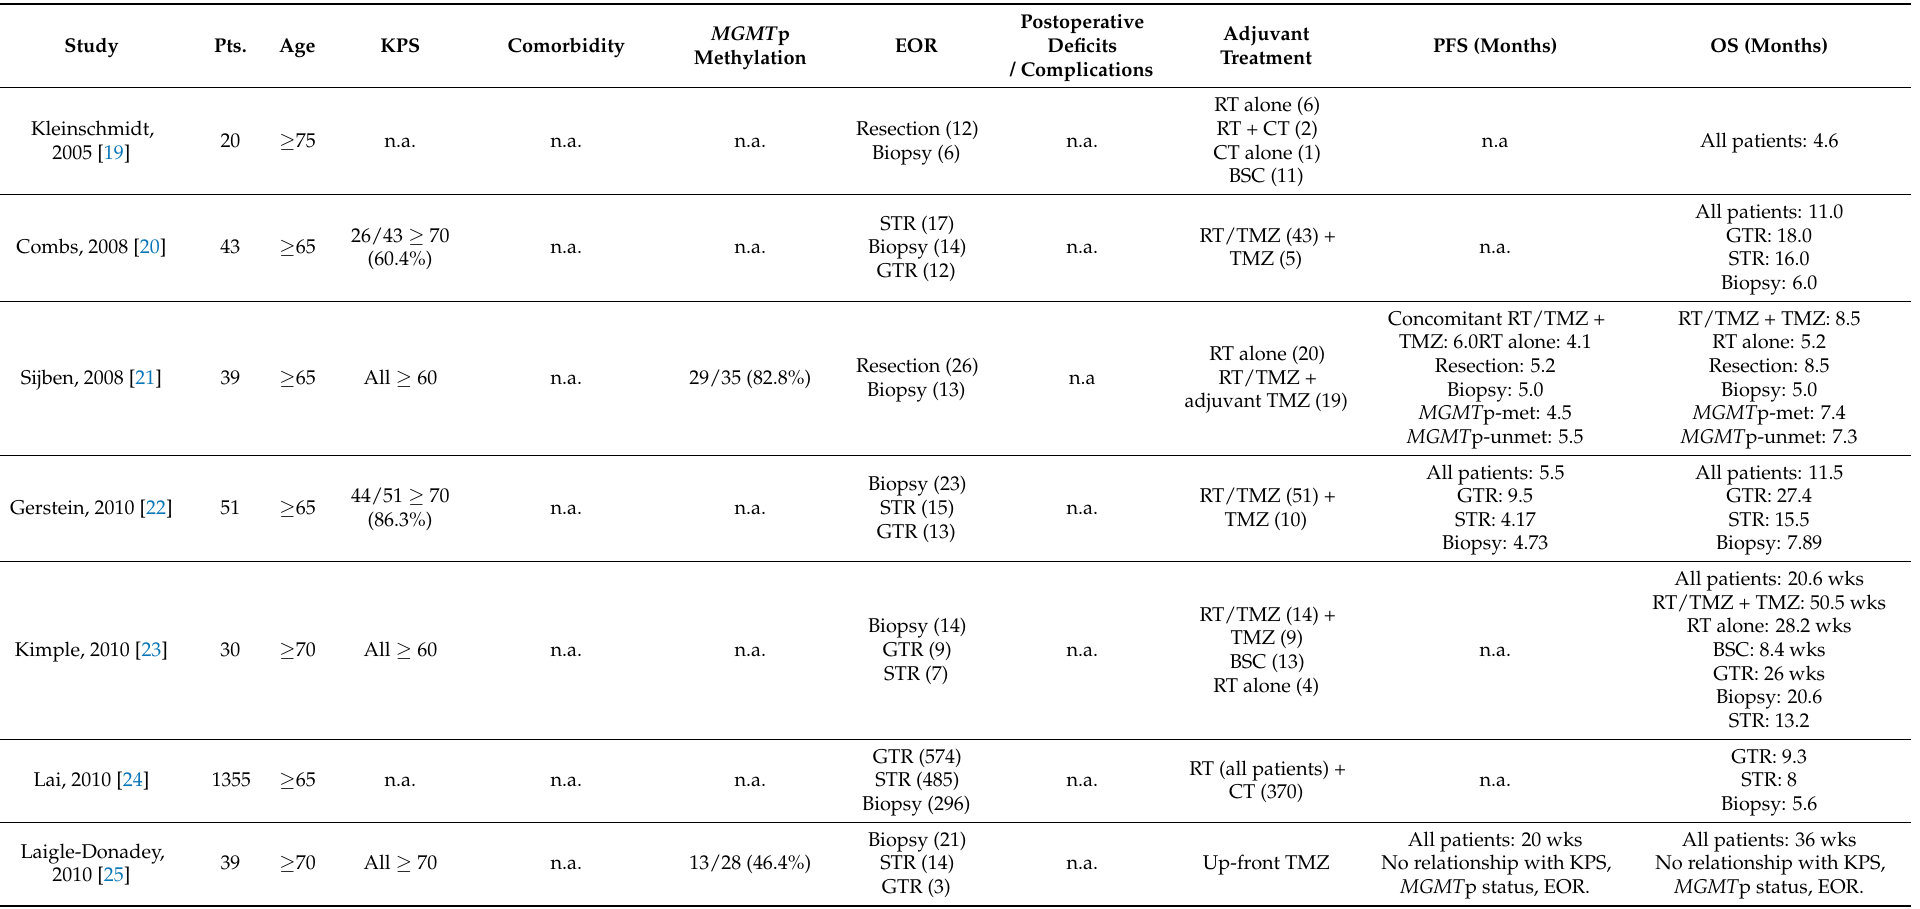
Table 10. Main clinical studies on elderly GBM patients investigating the role of EOR and adjuvant treatment on outcome. Study